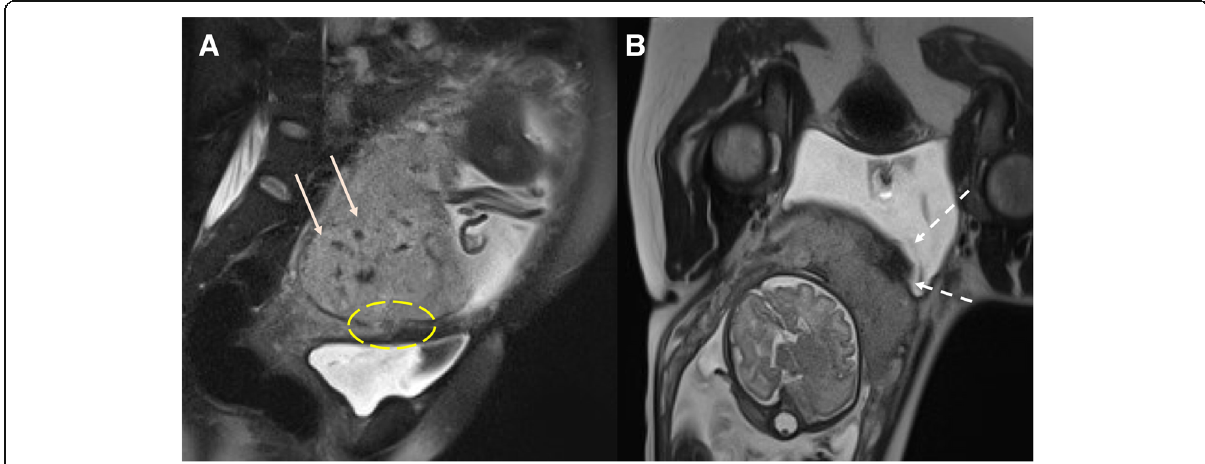
Fig. 17 Morbidity adherent placenta MR findings on T2-WI ( a , sagittal,Scientific Rep b , coronal): dark intraplacental bands (white arrows in a ), thinning or loss of the retroplacental dark zone (round dashed box in a ), and abnormal uterine bulge (dashed arrows in b